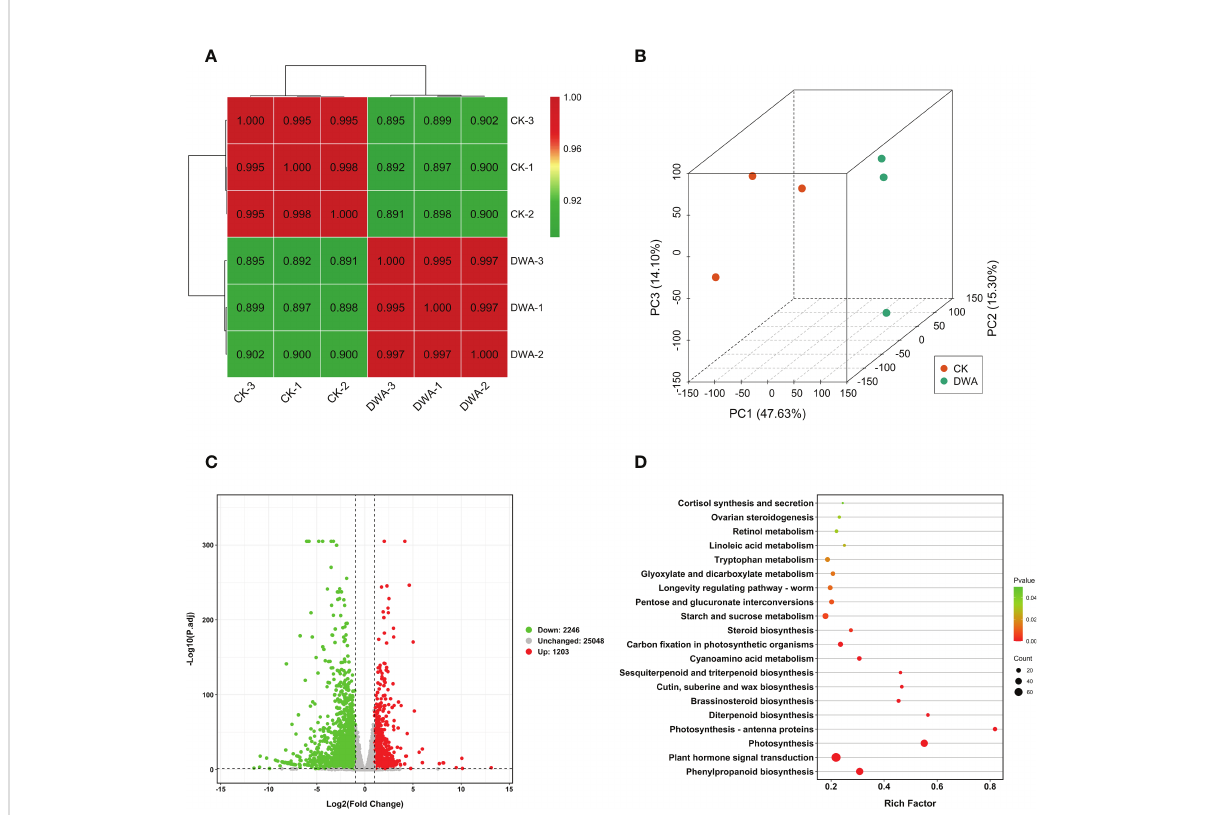
FIGURE 4 Transcriptome analysis of fl owering Chinese cabbage under uniconazole treatment. (A) Correlation heat map between the samples (based on fragments per kilobase of transcript per million fragments mapped). (B) Principal component analysis of transcriptome samples. (C) Volcano map of DEGs. (D) Kyoto Encyclopedia of Genes and Genomes pathway enrichment of DEGs. DEGs, differentially expressed genes; CK, 0 mg·L -1 uniconazole (pure water); DWA, 100 mg·L -1